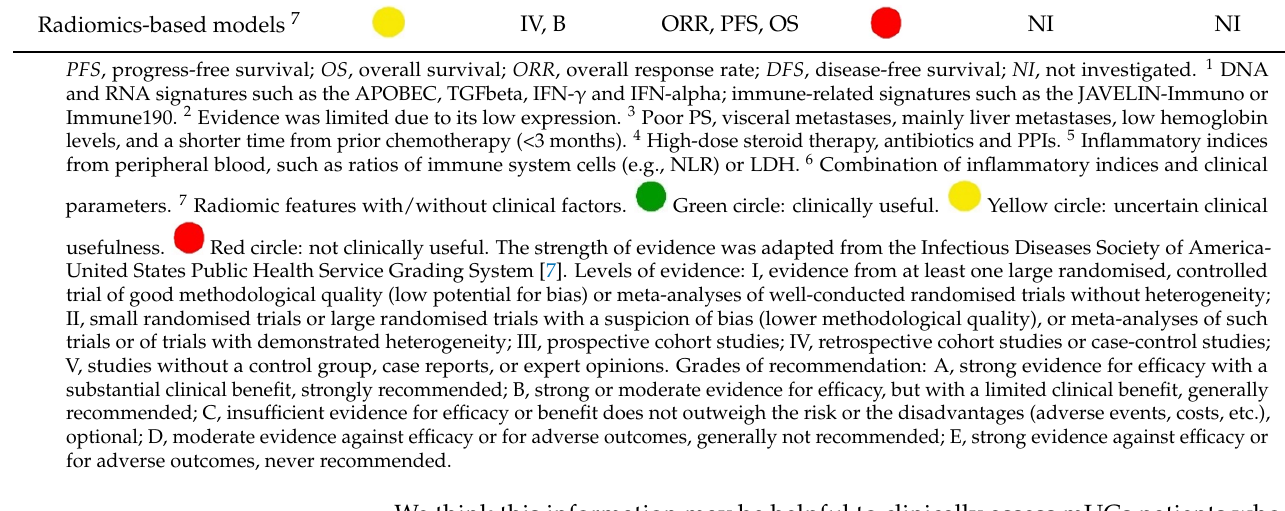
PFS, progress-free survival; OS, overall survival; ORR, overall response rate; DFS, disease-free survival; NI, not investi- gated. 1 DNA and RNA signatures such as the APOBEC, TGFbeta, IFN-γ and IFN-alpha; immune-related signatures such